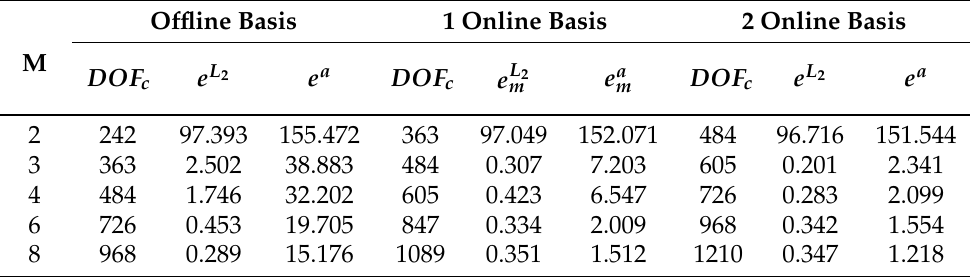
Figure 5. Numerical results for Test 1 . ( a ): fine grid solution. ( b ): multiscale solution using 3 offline basis functions. ( c ): multiscale solution using 3 offline basis functions and 1 online basis functions. Table 1. Numerical results for Test 1 . Relative L 2 and energy errors (%) for different number of offline multiscale basis functions using 1 and 2 online basis functions on the last time